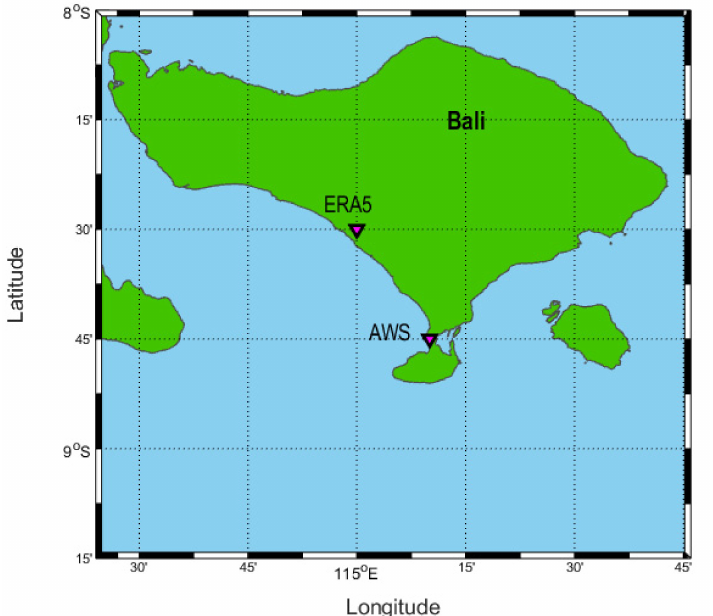
Figure 3. Location of Automatic Weather Station (AWS) in Ngurah Rai, Bali, and location of point for ERA5 data, in Bali Island, Indonesia.